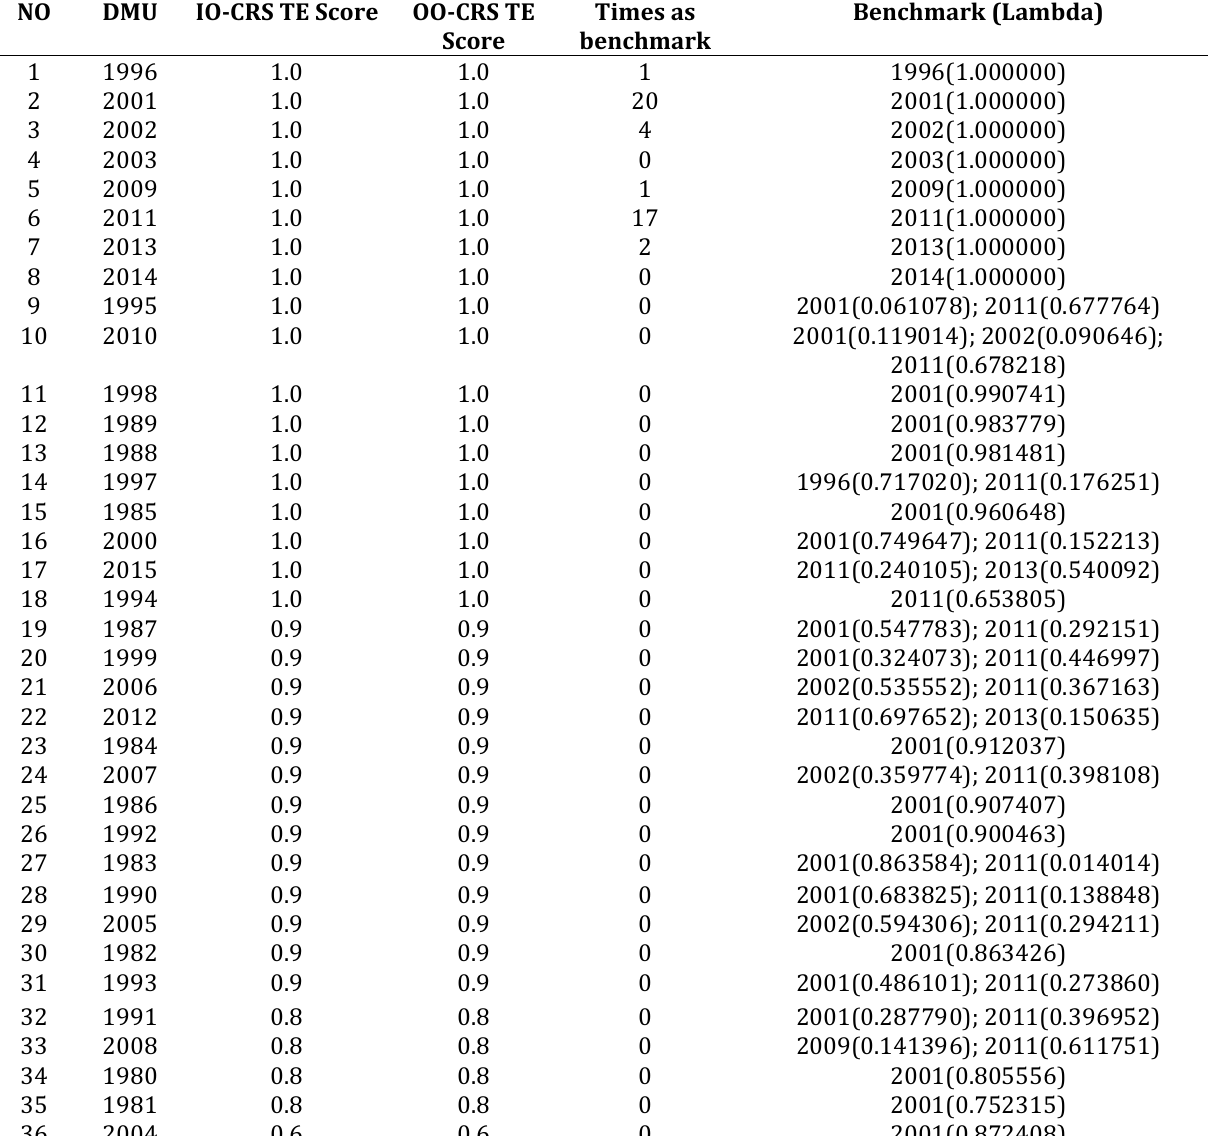
Table 8: Input-Oriented Technical Efficiency Benchmarking for Delta Port